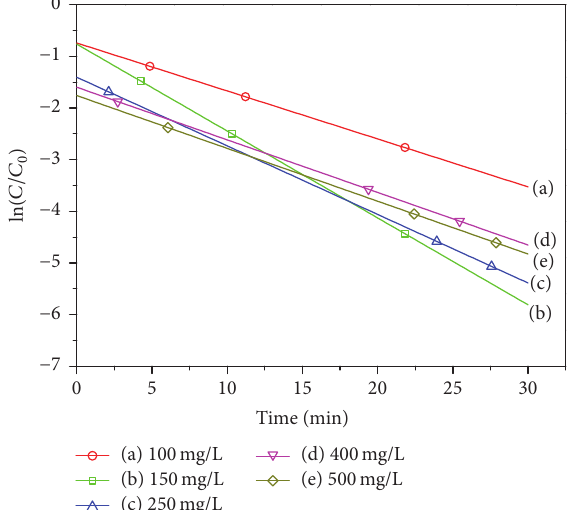
Figure 7: Kinetic for degradation of bromothymol blue with different concentration using 0.33 mM GZVINPs.